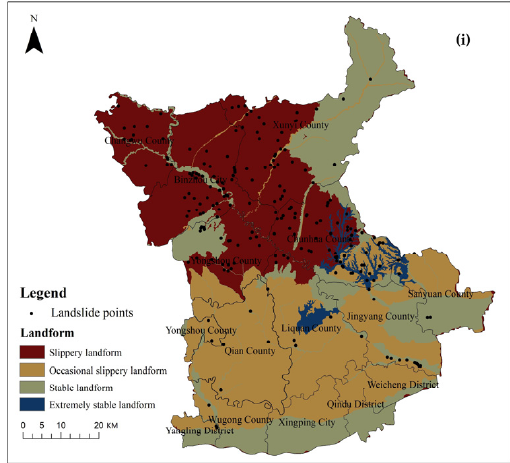
Figure 3. Landslide hazard assessment factors: ( a ) slope; ( b ) aspect; ( c ) elevation ; ( d ) NDVI; ( e ) distance from rivers; ( f ) distance from roads; ( g ) rainfall; ( h ) lithology; ( i ) landforms.